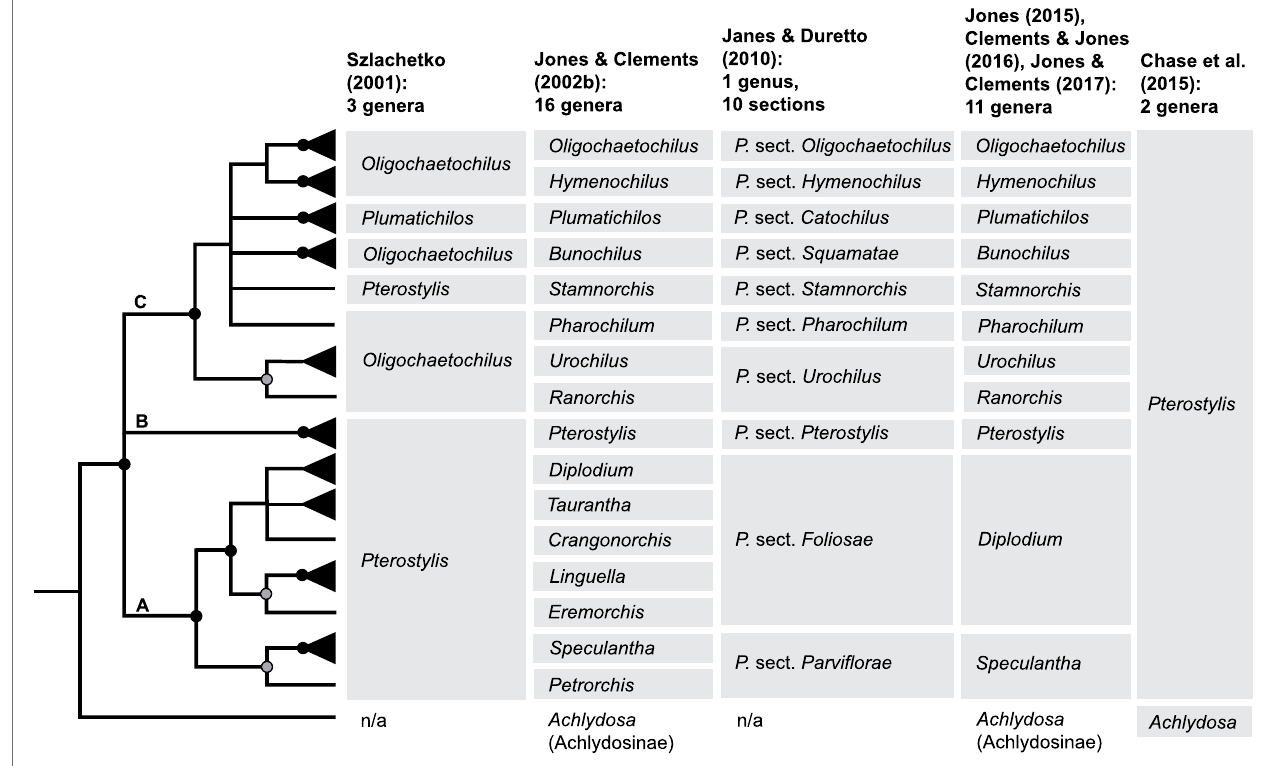
FIGURE 2 | Summary cladogram of phylogenetic relationships in Pterostylidinae based on Clements et al. (2011; modified) and systematic concepts in Pterostylidinae over the past two decades. Solid black circles denote nodes which received maximum support (Bayesian posterior probabilities of 1); grey circles denote moderately supported notes (posterior probabilities of 0.98–0.99). Monotypic taxa are depicted with a single line as terminals. Branches with lower support values (<0.95) are collapsed. Grey boxes highlight taxa which are considered part of Pterostylidinae in the respective classification. Taxa described prior to 2001 and publication years: sect. Catochilus Bentham and Von Mueller (1873); Diplodium Sw. (1810); sect. Foliosae G. Don (1830); sect. Parviflorae Bentham and Von Mueller (1873); Pterostylis R. Br. (1810) and sect. Squamatae G. Don (1830). For historic infrageneric classification systems for Pterostylidinae, see Jones and Clements